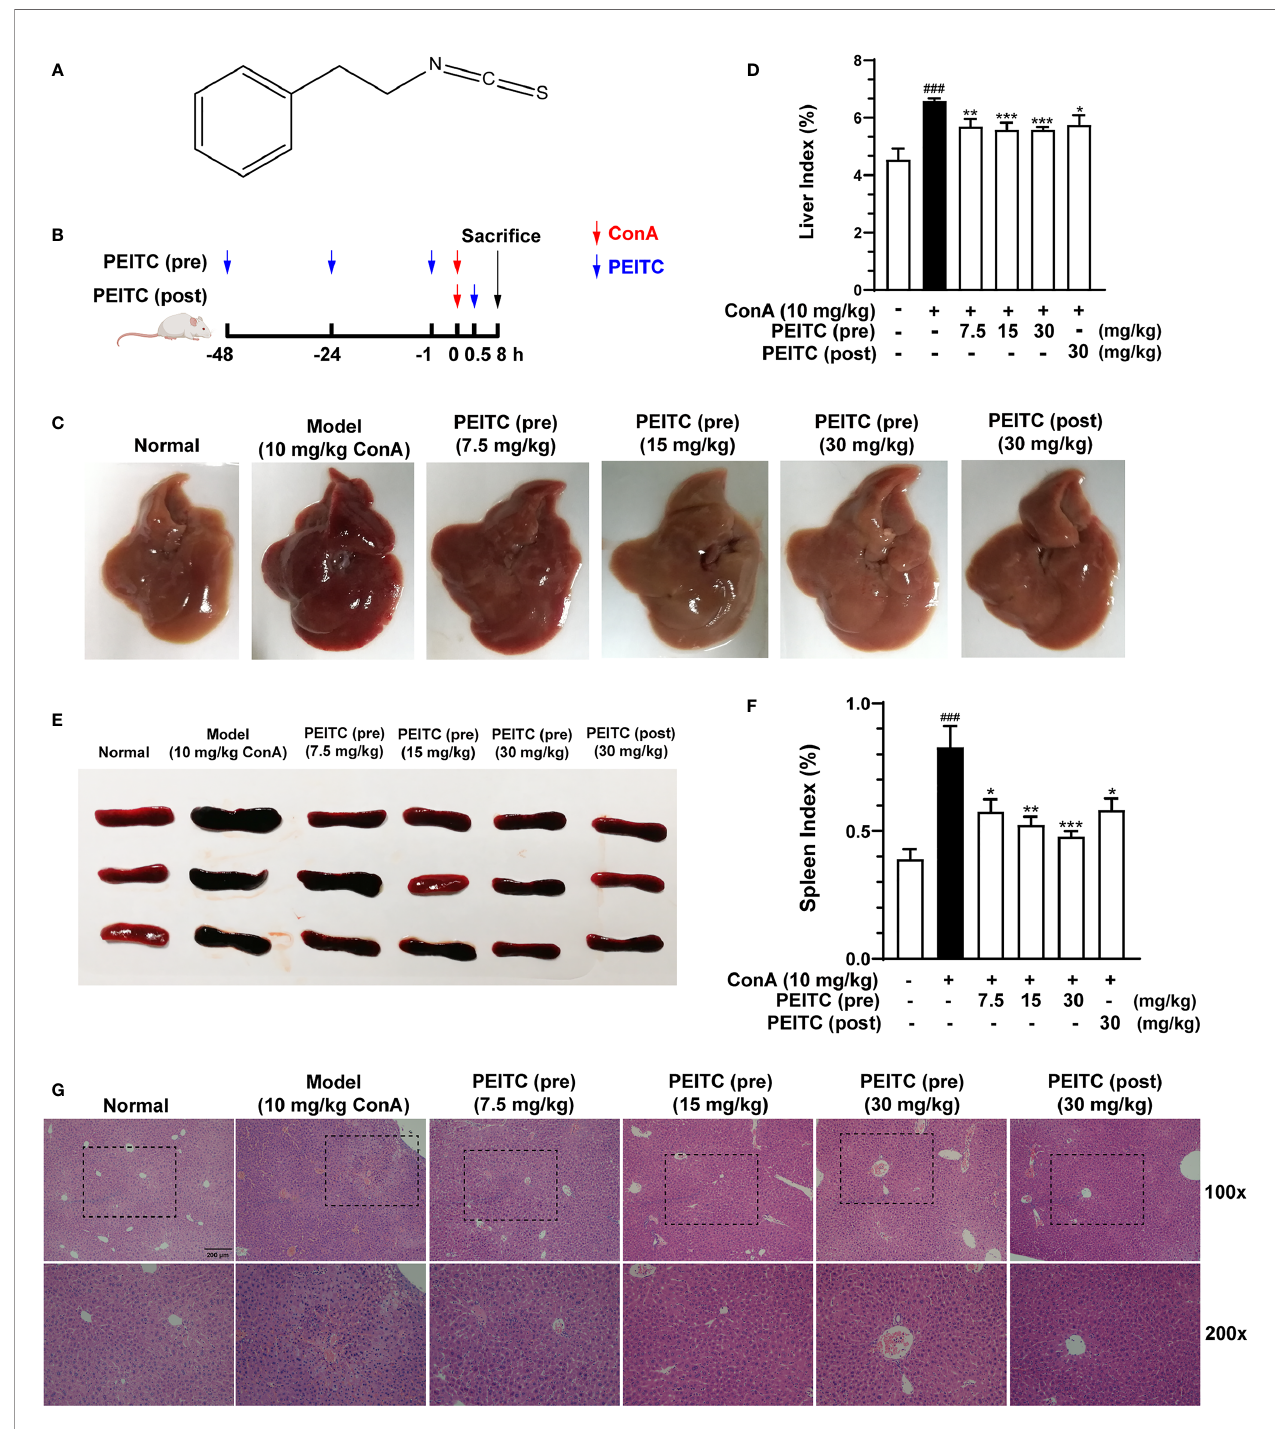
FIGURE 1 | PEITC ameliorated the acute immune liver injury model induced by ConA in mice. (A) Chemical structure of PEITC. (B) Schematic overview of the ConA-induced acute immune liver injury model. (C) The lesions on the surface of liver tissues were photographed and recorded. (D) The liver indexes were measured. (E) The lesions on the surface of spleen tissues were photographed and recorded. (F) The spleen indexes were measured. (G) Hematoxylin and eosin (H&E) staining of liver tissue sections. Scale bar, 200 µm. Data are presented as means ± SEM ( n = 10 per group). ### p < 0.001 vs. normal group, * p < 0.05, ** p < 0.01, *** p < 0.001 vs. ConA